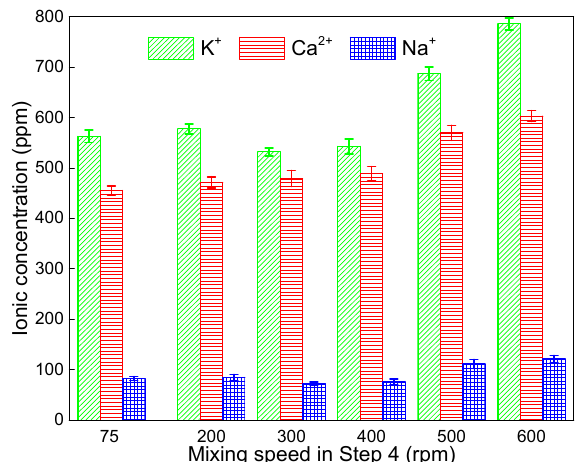
Figure 6. Results of the inductively coupled plasma mass spectrometry (ICP) test for CPB-D.